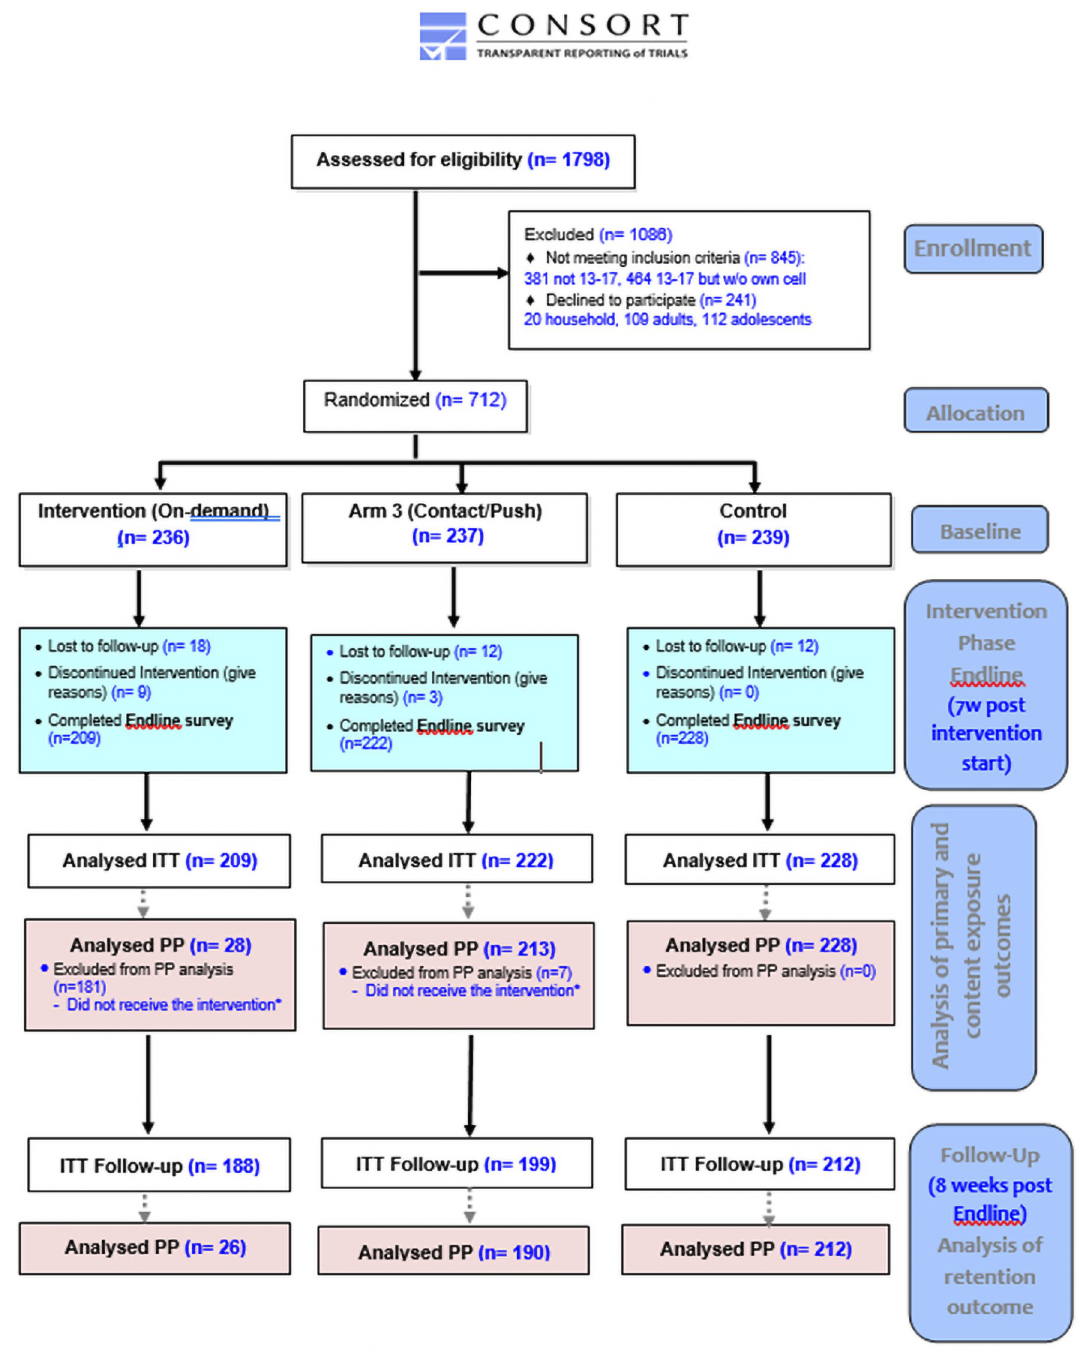
Fig 2. ARMADILLO Peru CONSORT flow diagram. � Participant that received the intervention is defined as someone who received text messages contained in ARMADILLO’S Domain 5: 1. For Arm 1 (on-demand): one Domain 5 menu (“welcome message”) AND requested 1+ message(s) 2. For Arm 2 (push): one Domain 5 message (“alert message”) AND the domain’s 10 informational messages successfully pushed.